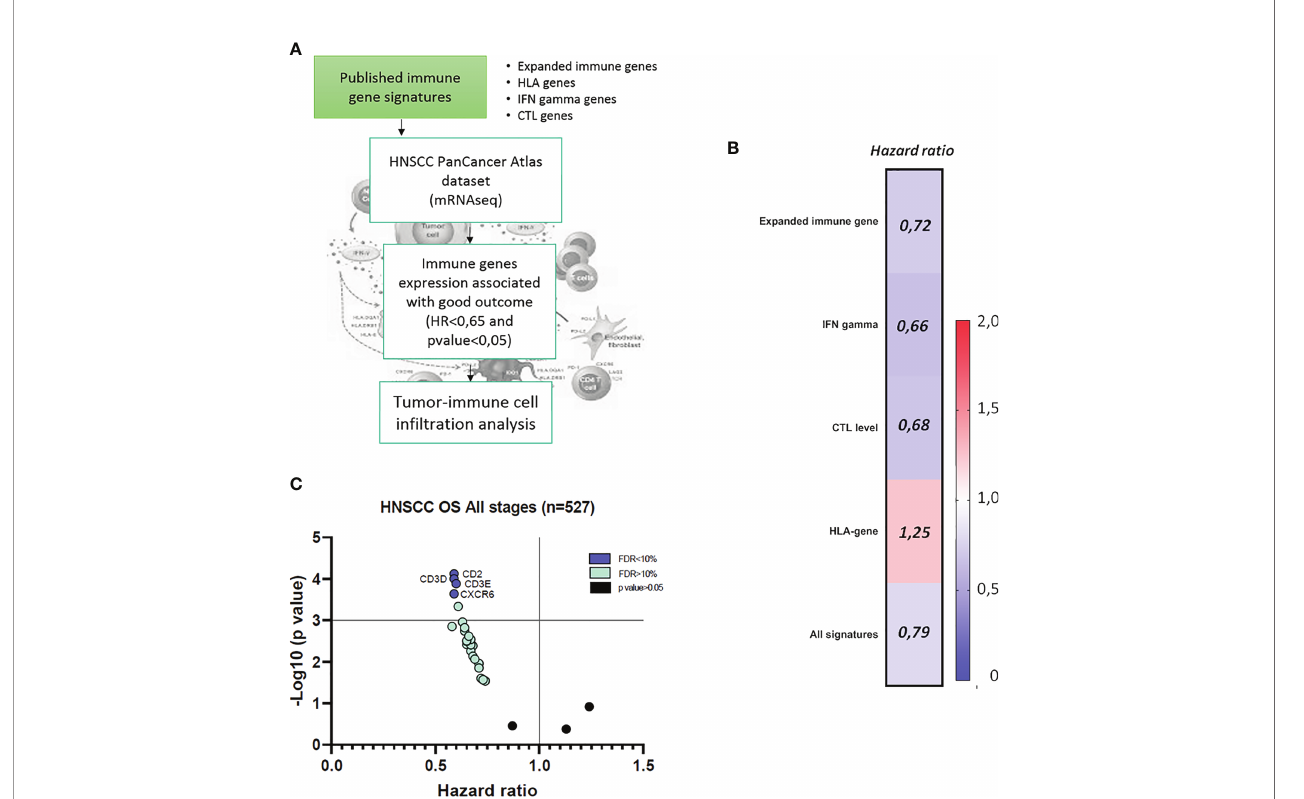
FIGURE 1 | Evaluation of the impact of immune gene signatures ( Expanded immune genes, IFN gamma genes , CTL level , and HLA genes ) on clinical outcome in Head and Neck Squamous Cell Carcinoma (HNSCC) patients. (A) Flow chart of the analysis of the four published immune gene signatures and the transcriptomic expression effect in HNSCC patients ’ clinical outcome and the correlation with tumor immune cell in fi ltrate composition. (B) Hazard ratio (HR) heat map for risk of death of each published immune gene signatures ( Expanded immune genes , IFN gamma genes , CTL levels , and HLA genes) and combined, in association with overall survival (OS) in HNSCC patients at all stages (n = 527), using data from TCGA database as described in Materials and Methods . HR < 1 discriminates a risk reduction. Blue color represents favorable prognosis, and red color represents detrimental prognosis, with 95% con fi dence interval (CI) and p value < 0.05. (C) Graph representation of immune genes with the most favorable outcome in HNSCC (HR < 1, p value < 0.05 and FDR < 10%), in blue spots. Green spots represent immune genes with good prognosis and FDR > 10% and p < 0.05. Black spots represent immune genes without statistical signi fi cance (p value >